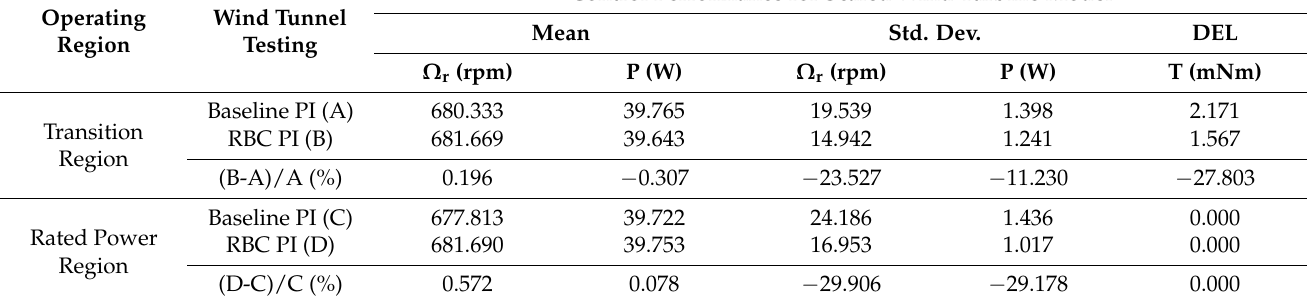
Table 3. Quantitative comparison of control performance for scaled wind turbine model during wind tunnel testing.